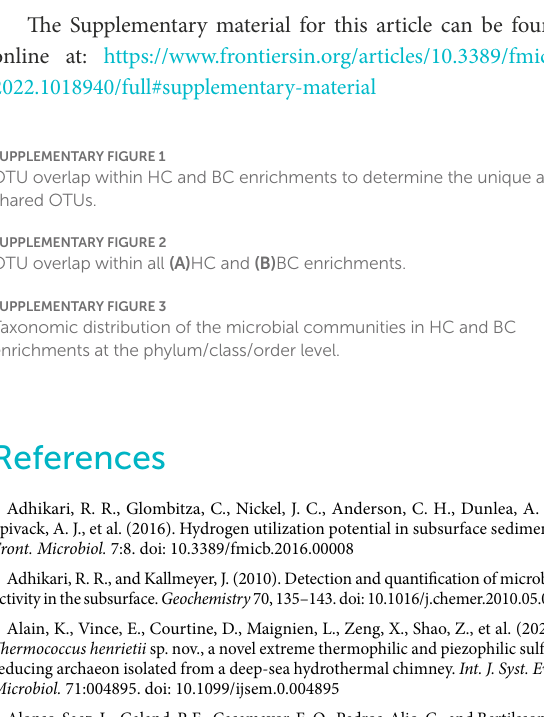
abundant OTUs (abundance <0. 1%) detected in (A) HC and (B) BC enrichments. SUPPLEMENTARY FIGURE 6 Heatmap of the Spearman correlation based on abundance of all microbial phyla detected in HC enrichment (abundance values are mentioned in the first bracket). SUPPLEMENTARY FIGURE 7 Heatmap of the Spearman correlation based on abundance of all microbial phyla detected in BC enrichment (abundance values are mentioned in the first bracket). SUPPLEMENTARY FIGURE 8A Co-occurrence network of microbial communities (taxa level) in HC enrichment positively correlated with sample’s depth. Node colour are proportional to the number of degrees. Nodes with higher degree are orange in colour than those with lower connections. Colour of the edges represents the strength of the Spearman’s correlations between the nodes. Edges with stronger correlation are orange in colour. Burkholderia-Caballeronia-Paraburkholderia is designated as Bur-Cab- Para. SUPPLEMENTARY FIGURE 8B Co-occurrence network of microbial community (taxa level) in HC enrichment negatively correlated with sample’s depth. Node colour are proportional to the number of degrees. Nodes with higher degree are green in colour than those with lower connections. Colour of the edges represents the strength of the Spearman’s correlations between the nodes. Edges with stronger correlation are green in colour. SUPPLEMENTARY FIGURE 9A Co-occurrence network of microbial community (taxa level) in BC enrichment positively correlated with sample’s depth. Node colour are proportional to the number of degrees. Nodes with higher degree are orange in colour than those with lower connections. Colour of the edges represents the strength of the Spearman’s correlations between the nodes. Edges with stronger correlation are orange in colour. Burkholderia-Caballeronia-Paraburkholderia is designated as Bur-Cab- Para. SUPPLEMENTARY FIGURE 9B Co-occurrence network of microbial community (taxa level) in BC enrichment negatively correlated with sample’s depth. Node colour are proportional to the number of degrees. Nodes with higher degree are green in colour than those with lower connections. Colour of the edges represents the strength of the Spearman’s correlations between the nodes. Edges with stronger correlation are green in colour. SUPPLEMENTARY FIGURE 10 Neighbour joining tree based on top 30 OTUs and cyanobacterial OTU sequences and their related organisms showing phylogenetic relationship. Numbers at the nodes represent the bootstrap value (1,000 replicates). The colour codes depict the presence and abundance of OTUs in sample zones. S-Shallower rock enrichments (average of